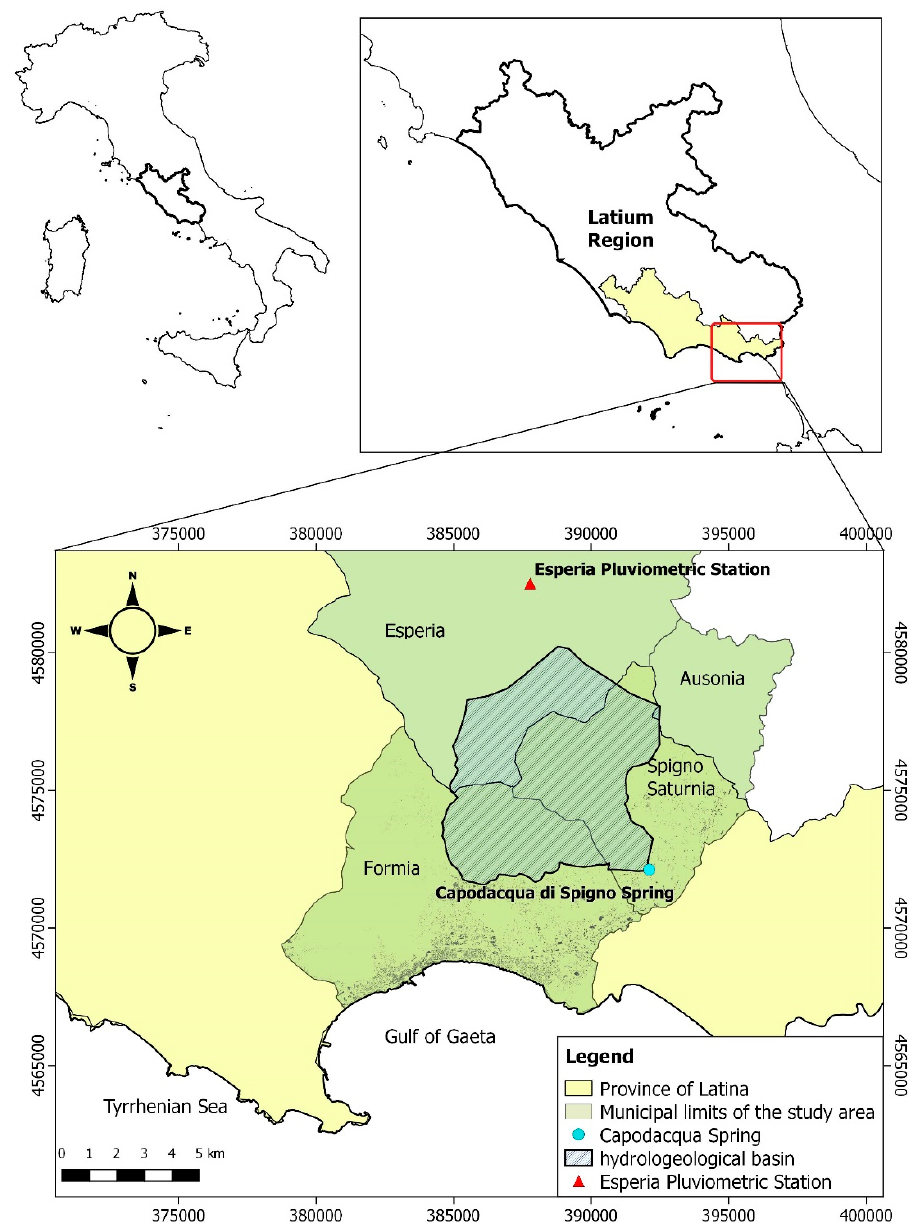
Figure 1. Territorial framework of the study area (WGS84 coordinates in meters).